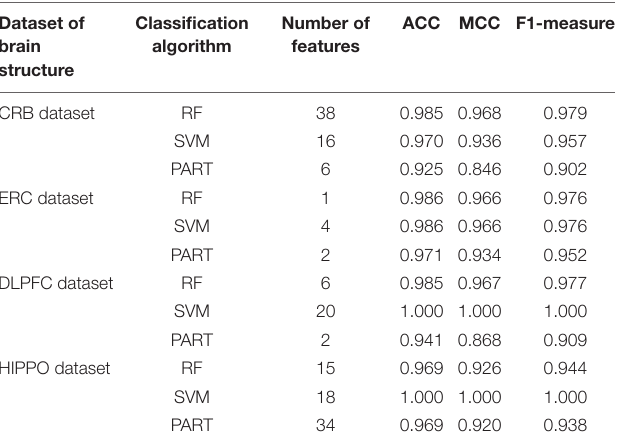
TABLE 2 | Performance of the optimal classifiers based on different classification algorithms on four brain structures. Dataset of brain